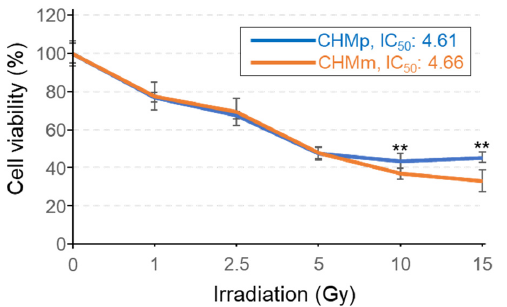
Figure 2. Cell survival after irradiation of CHMp and CHMm. Cells were treated with increasing intensities of radiation (0, 1, 2.5, 5, 10, 15 Gy). After 72 h, the IC 50 values and cell viability using